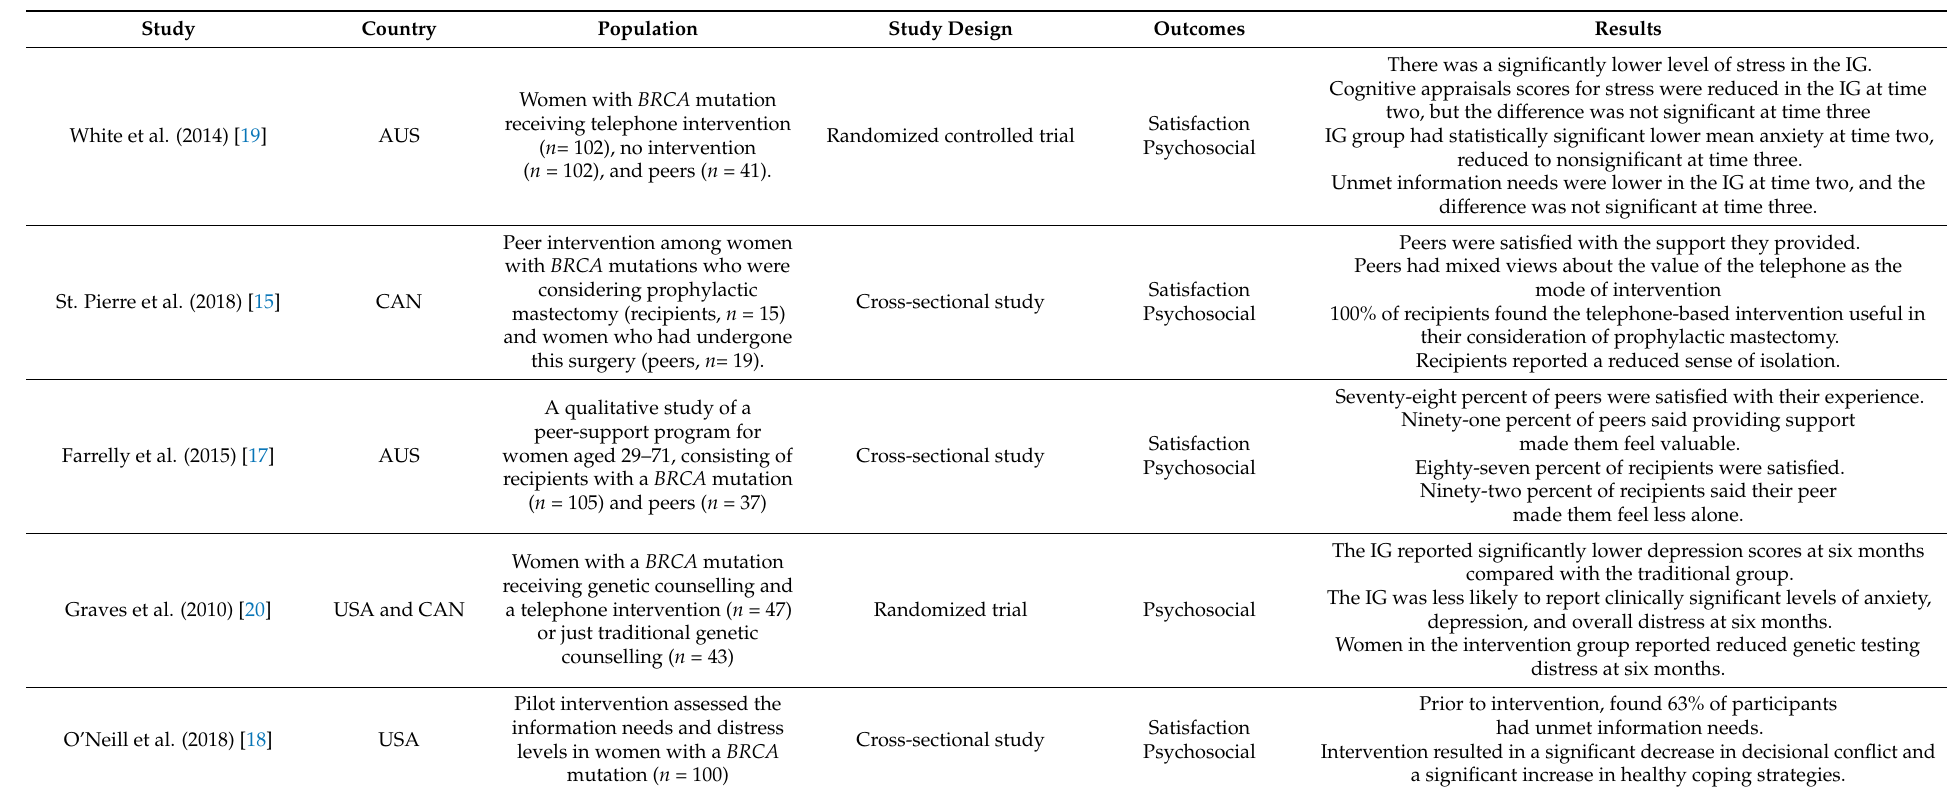
Table 1. Telephone-based